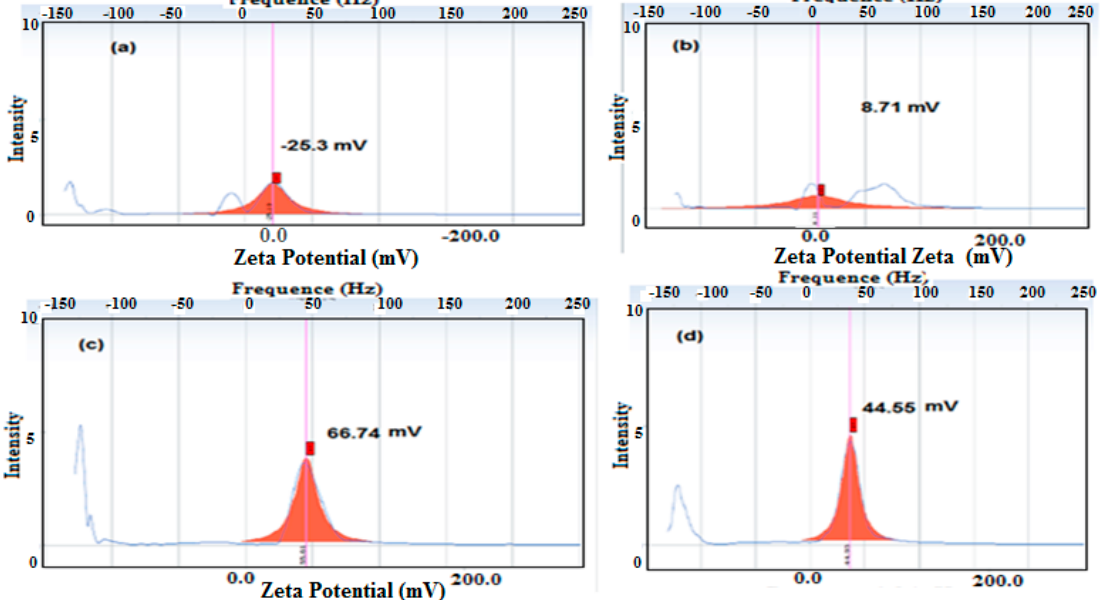
Figure 3. Zeta potential data of the hydrophobic SNP. ( a ) HSNP, ( b ) HOSNP, ( c ) EOSNP1, and ( d ) EOSNP2 in ethanol/water, at 25 °C.